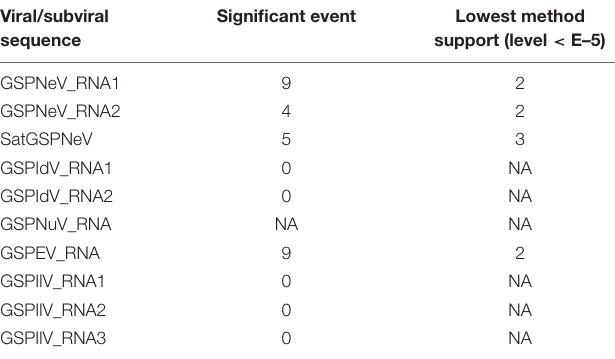
TABLE 2 | Recombination events prediction for the viral/subviral RNAs. Viral/subviral